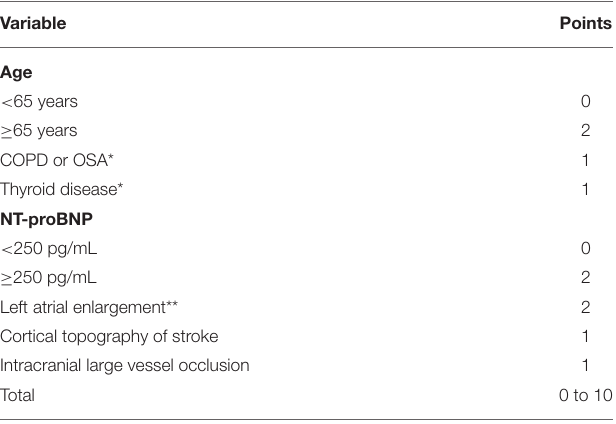
TABLE 2 | Proposed scoring in SAFE.